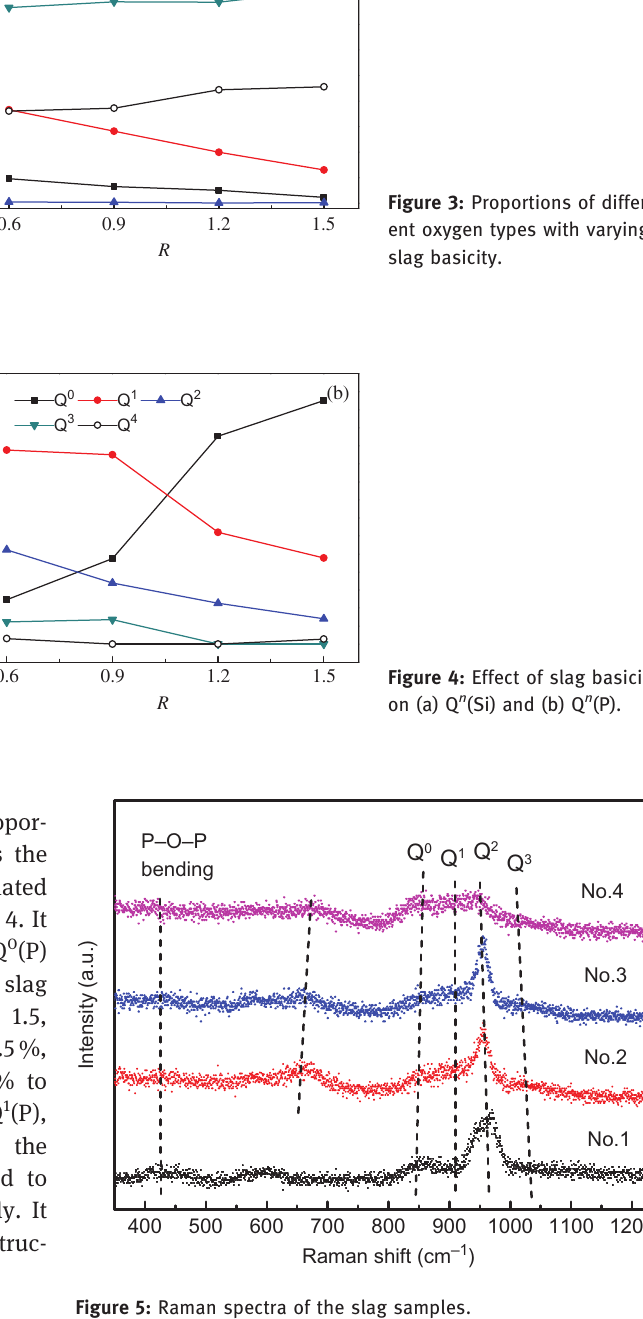
Figure 5: Raman spectra of the slag